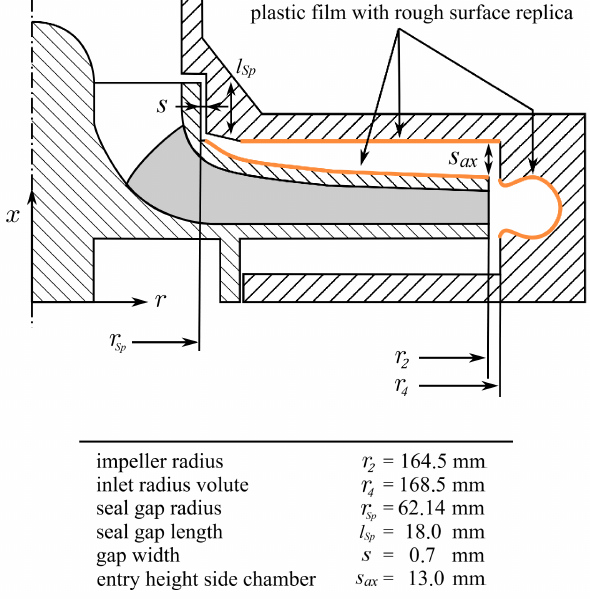
Figure 14. Most important geometric parameters of the pump and position of the adhered plastic films to study the roughness effect in the pump. Shown in a meridional section through the impeller, side chambers, and the